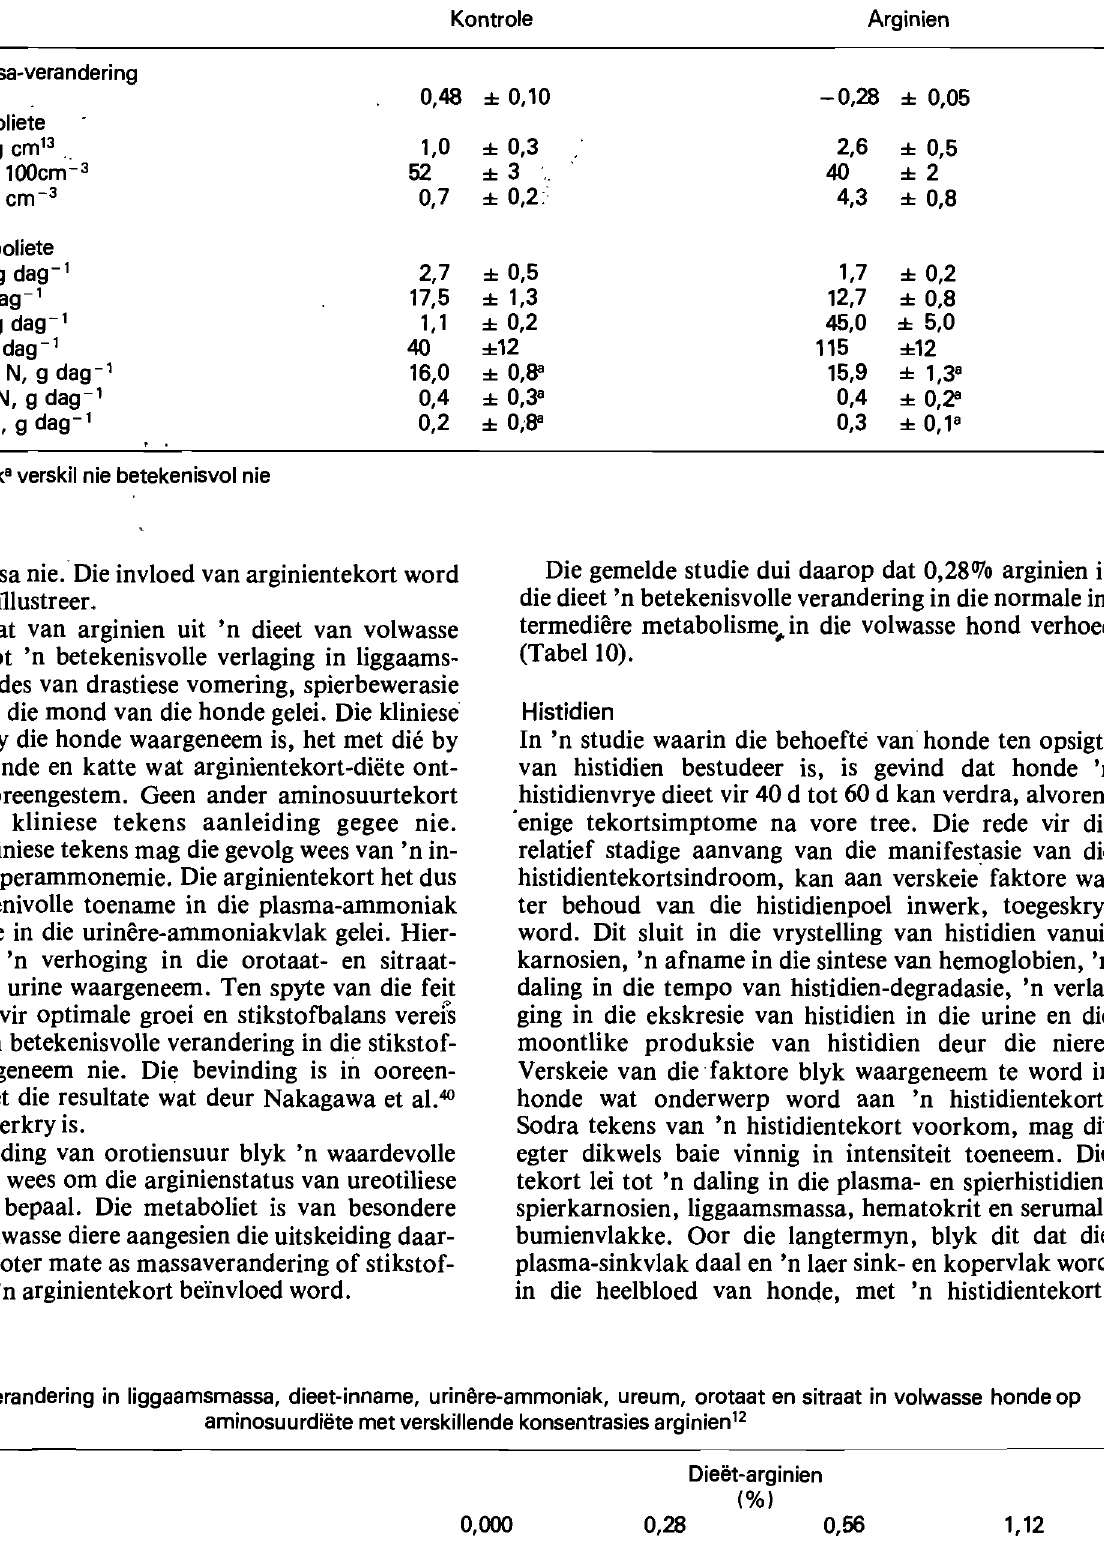
Tabel 10: Verandering in liggaamsmassa, dieet-inname, urinere-ammoniak, ureum, orotaat en sitraat in volwasse honde op aminosuurdiete met verskillende konsentrasies arginien